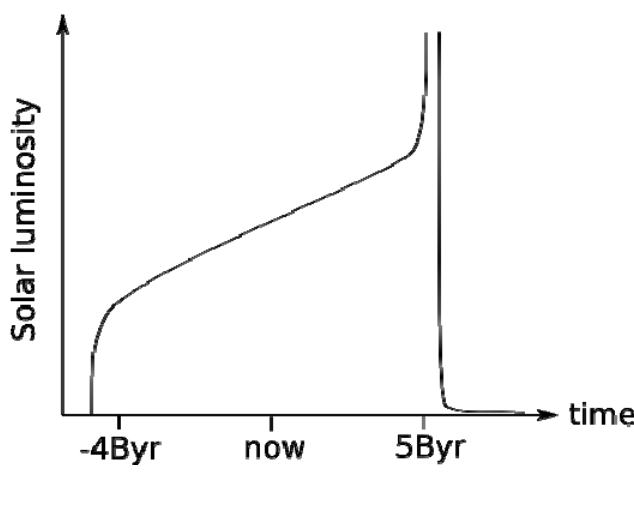
Figure 1. Schematic of the sun’s